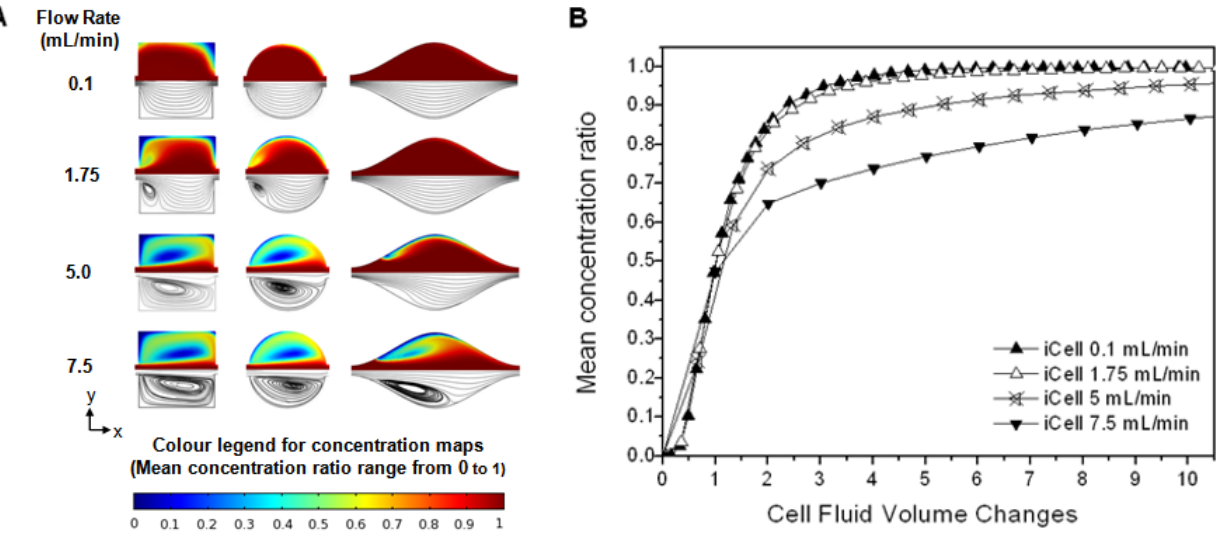
Figure 5. Computational results showing ( A ) concentration maps (top) and streamlines (bottom), after 5 flow cell volume changes and taken through the mid-plane for four selected flow rates; ( B ) Response of flow cell to injection of analyte for iCell at four selected flow